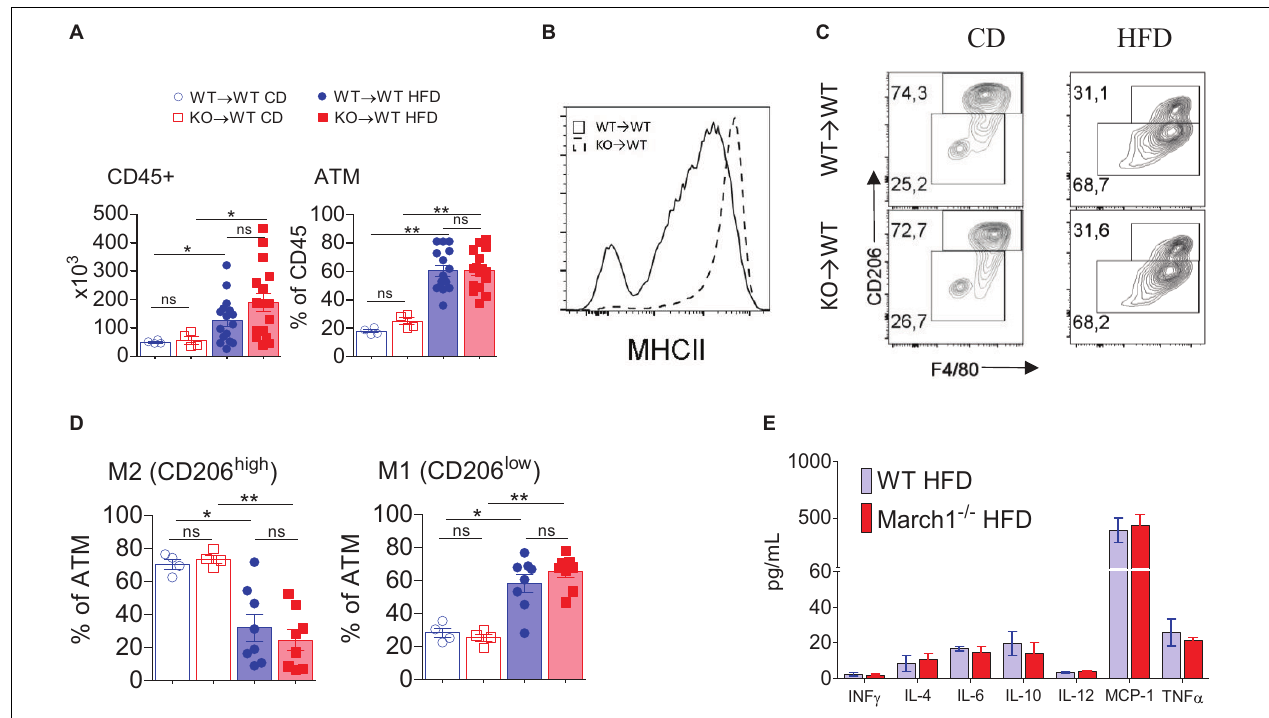
FIGURE 2 | Normal ATM polarization in AT from mice lacking March1. Stromal Vascular Fraction (SVF) cells were isolated by enzymatic digestion of AT from obese and lean BMC. Flow cytometry analysis of SVF for total CD45 + cells (A-left) and total ATM proportions (A-right) . MHCII surface expression (B) was analyzed in ATM from KO → WT and WT → WT obese mice. Representative dot-plots (C) and proportions (D) of M1 and M2 ATM defined based on the expression of CD206. Cytokine content of total SVF measured by CBA (E) . ∗ P < 0.05 and ∗∗ P < 0.01.